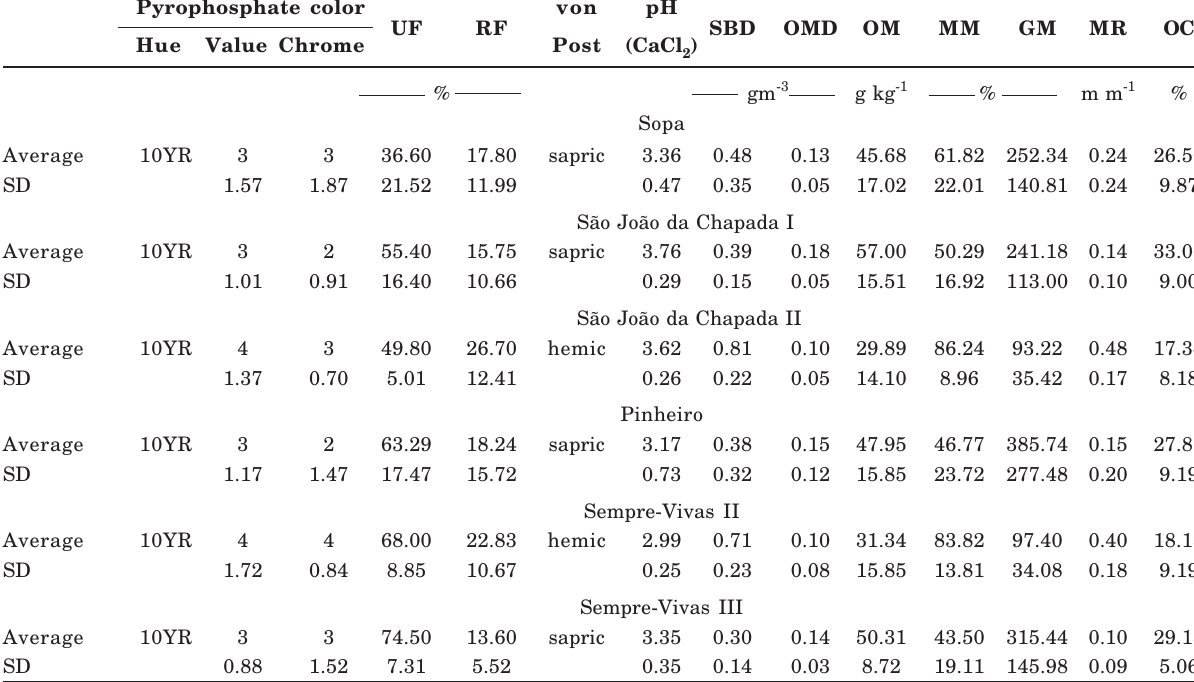
Table 1. Average morphological, physical and chemical properties of six peatlands in the SdEM